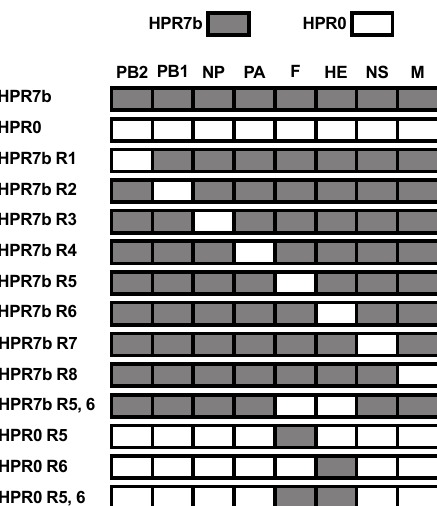
Figure 1. Genetic arrangement of reassortant viruses produced in this study. Genetic composition of each virus generated in this work. Grey denotes HPR7b segments, and white represents HPR0 segments. PB2: Segment 1; PB1: Segment 2; NP: Segment 3; PA: Segment 4; F: Segment 5; HE: Segment 6; NS: Segment 7; M: Segment 8. Each name refers to the genetic backbone, HPR7b or HPR0, and the “R” refers to the reassorted segment.